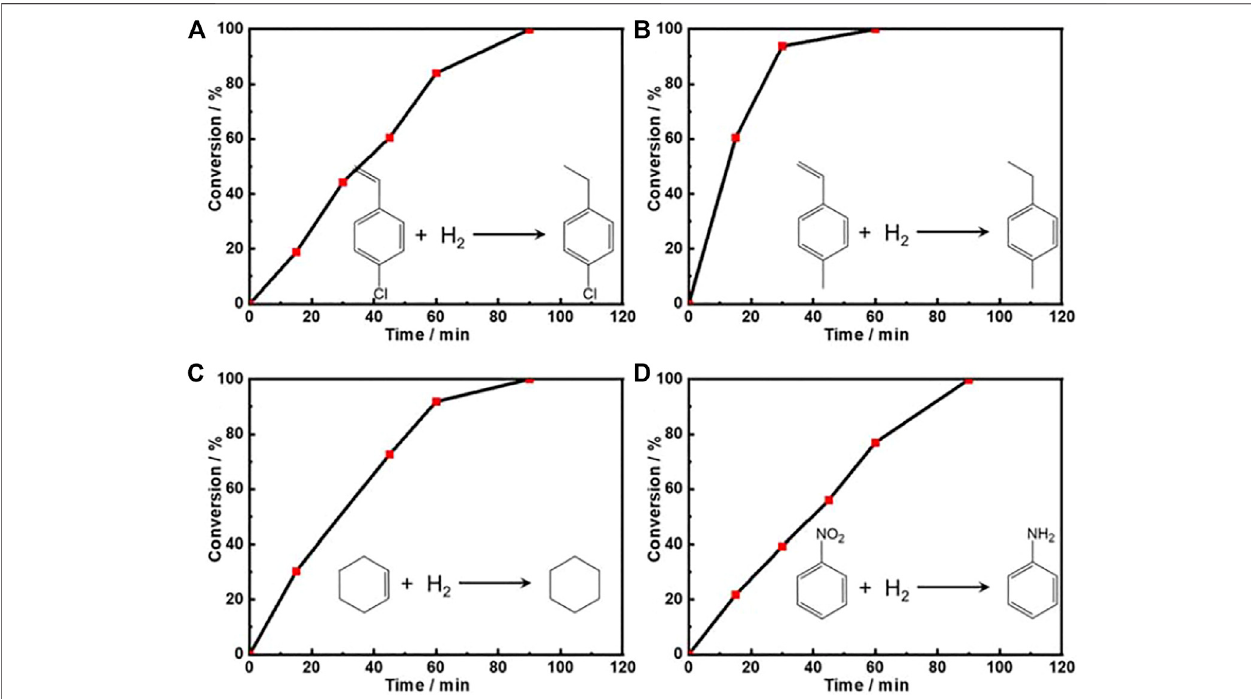
Frontiers in Chemistry |